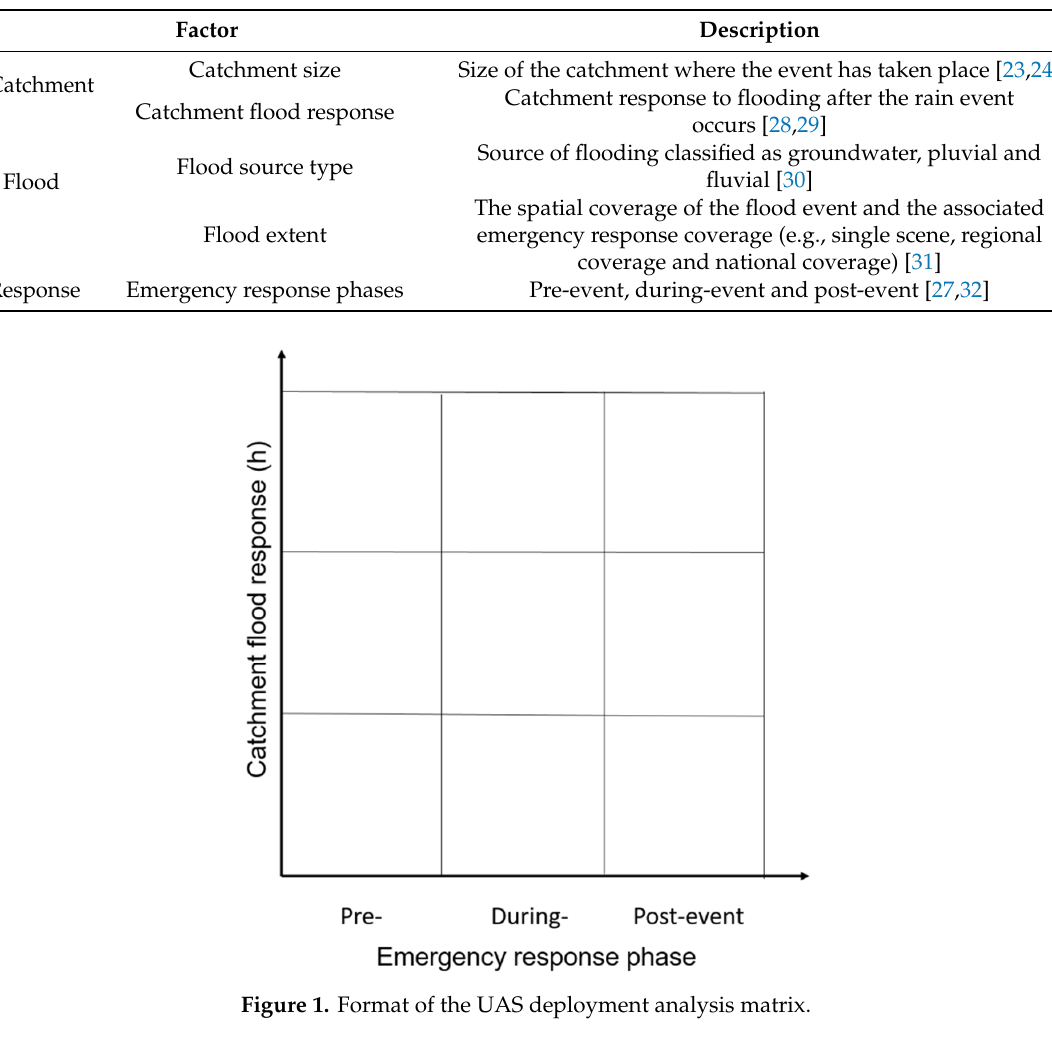
Table 1. Key factors identified as relevant for the development of the Unmanned Aircraft Systems (UAS) deployment analysis matrix.